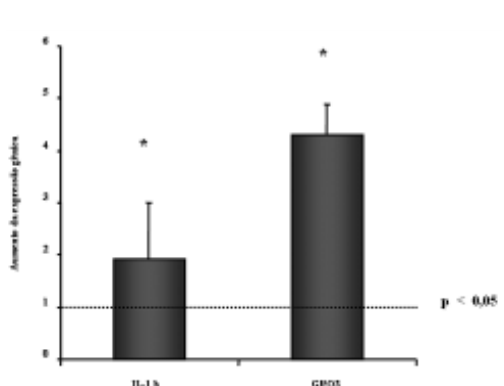
Fig. 8 - Análise de expressão gênica por metodologia quantitativa (RT-PCR) em tempo real. O gráfico representa valores da expressão da veia safena cultivada em regime hemodinâmico arterial em relação aos valores da veia safena cultivada em regime venoso (linha tracejada). Observa-se elevação da expressão da Interleucina 1ß e do Oncogene 3 nas veias cultivadas sob condição arterial